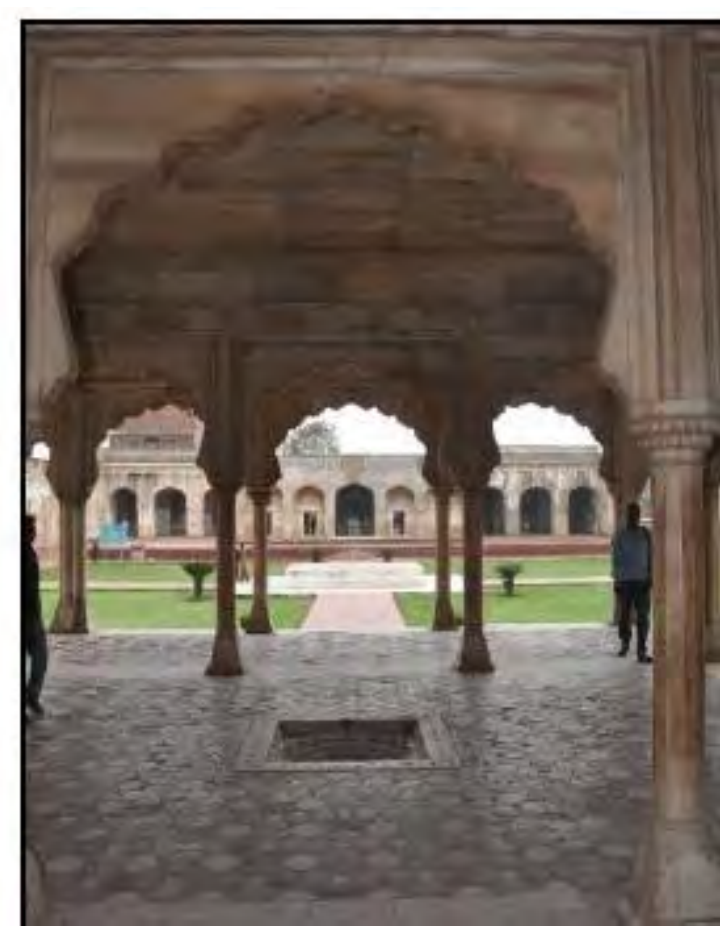
Figure 11. Fountain inside Diwan e Khas